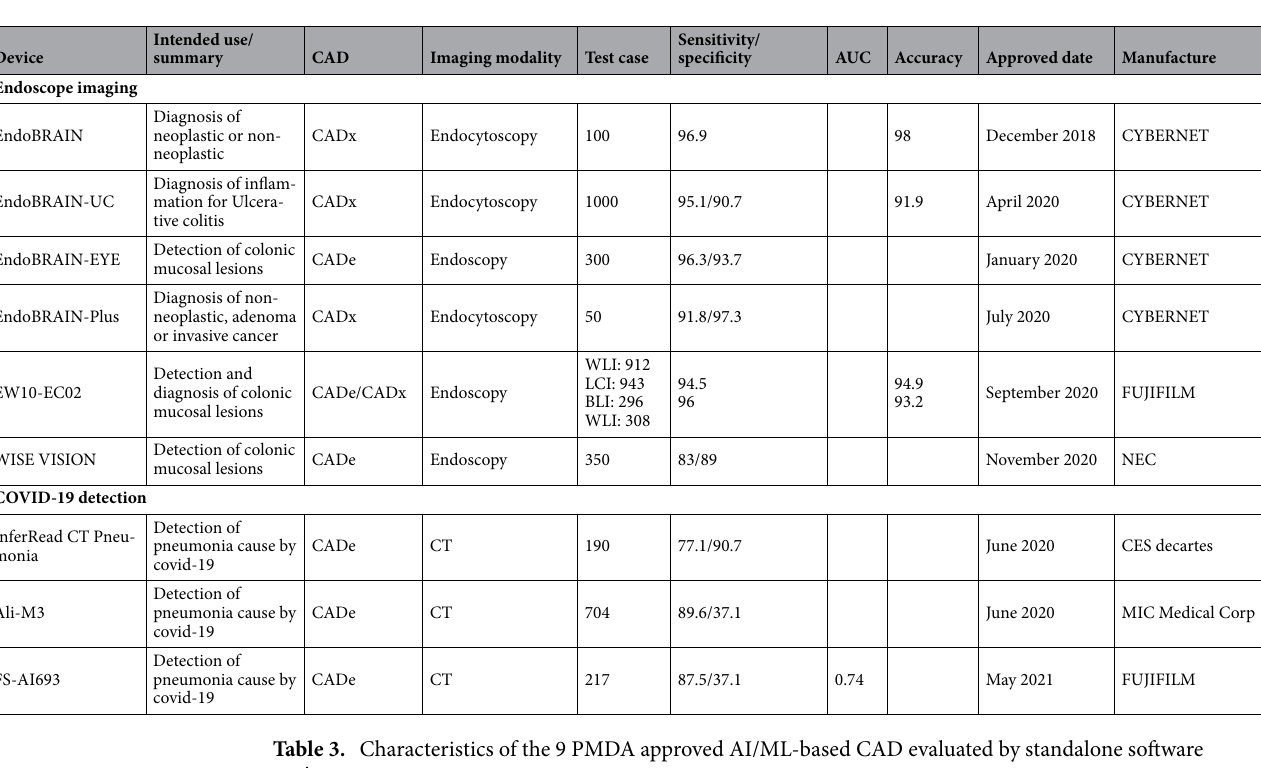
Table 3. Characteristics of the 9 PMDA approved AI/ML-based CAD evaluated by standalone software testing.